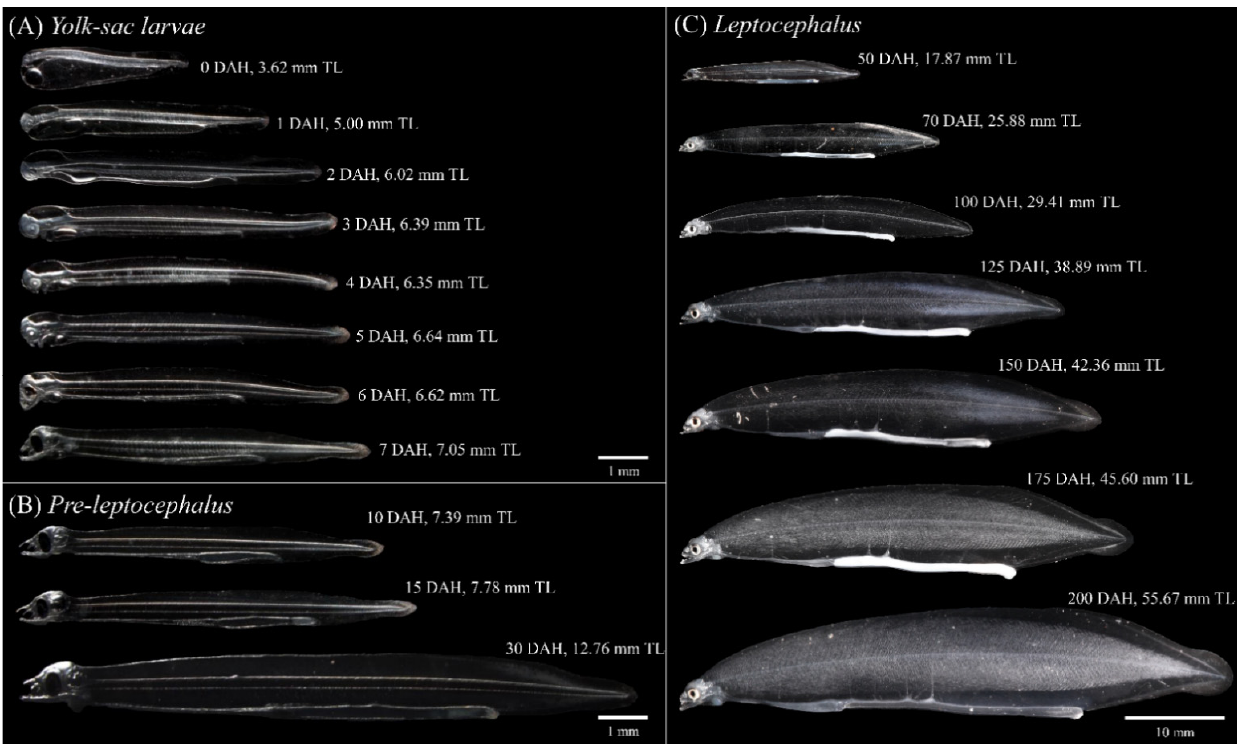
Figure 5. Morphological development in early ontogeny of Anguilla japonica larvae. ( A ) Yolk sac larval stage. ( B ) Pre-leptocephalus stage. ( C ) Leptocephalus stage. Abbreviations: DAH, days after hatching; TL, total length.